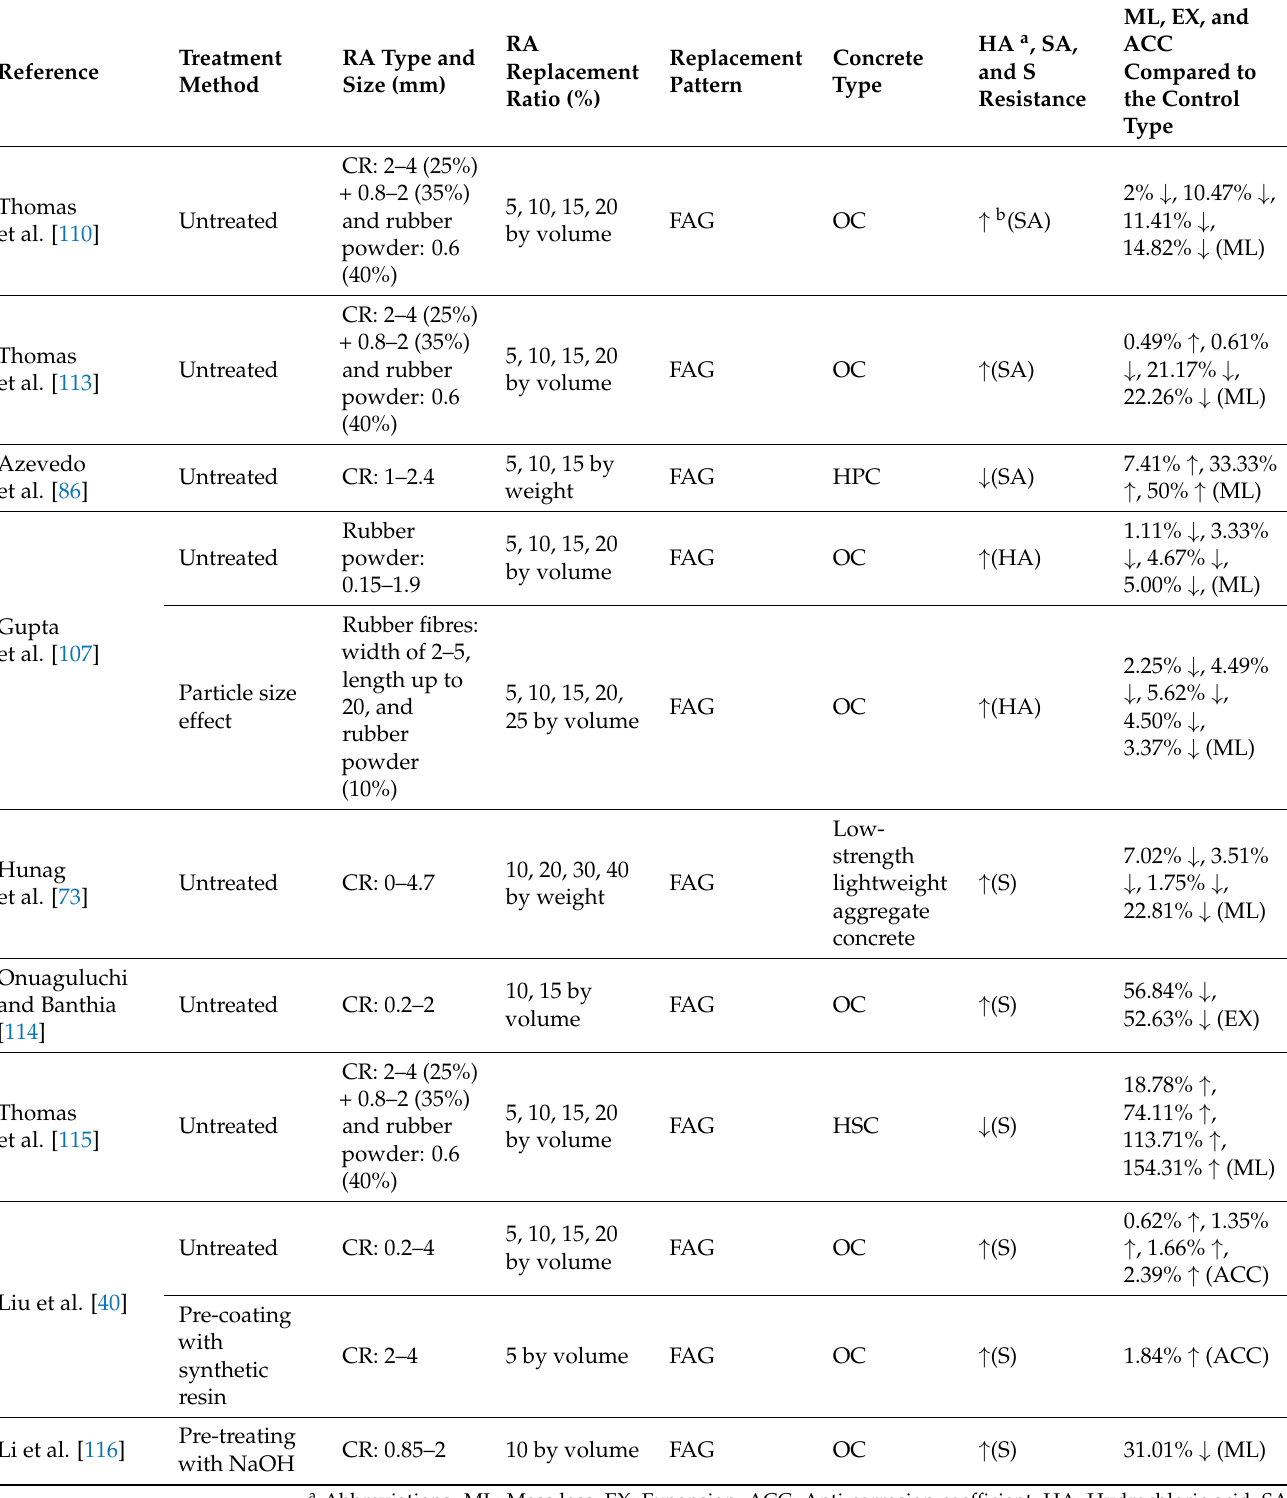
Table 9. Influence of rubber on the concrete acid and sulphate